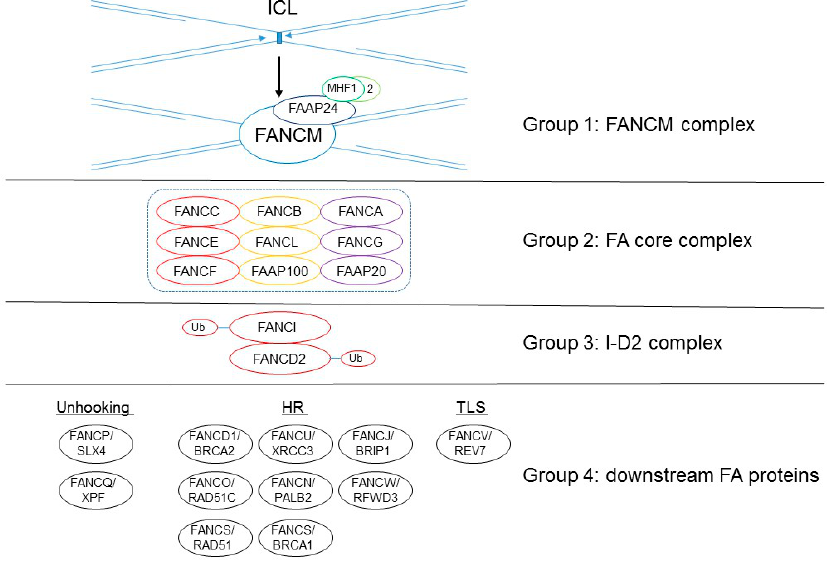
Figure 1. The 22 FANC proteins are classified into four groups according to their proposed functions in ICL repair. Recent cryo-electron microscopy (EM) studies have determined the fine structure of the FA core complex (group 2), which comprises nine proteins organized in three subcomplexes: BL100 (composed of two copies of FANCB, FANCL, and FAAP100), CEF (composed of a single copy of FANCC, FANCE, and FANCF), and AG20 (composed of two copies of FANCA and FANCG and 1 or 2 copies of FAAP100) [12–15]. Unhooking: ICL removal by cutting the activity of the